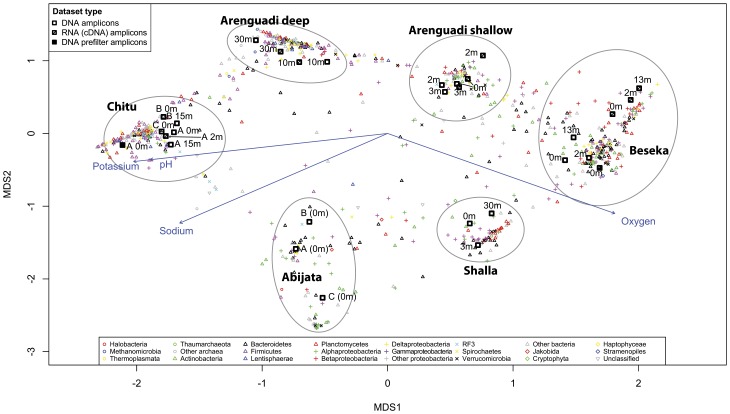
Non-metric multidimensional scaling (NMDS) based on Bray-Curtis dissimilarities between OTU compositions of individual datasets.Sequence datasets OTUs and fitted physicochemical parameters are plotted on the first two NMDS axes. The colors and shapes of individual OTUs and sequence datasets represent their taxonomical classification or dataset type, according to the legends.